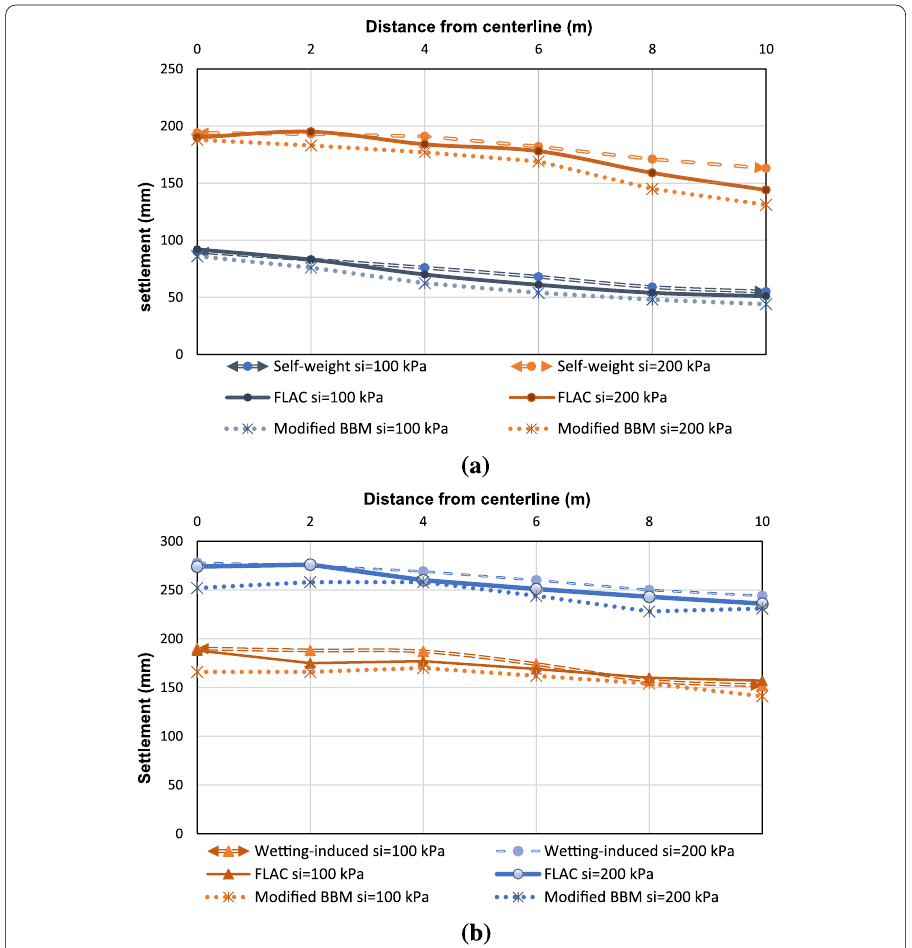
Fig. 16 Comparison of initial suction effect on settlements of the model surface in various situations for: a Self-weight settlements; b Wetting-induced